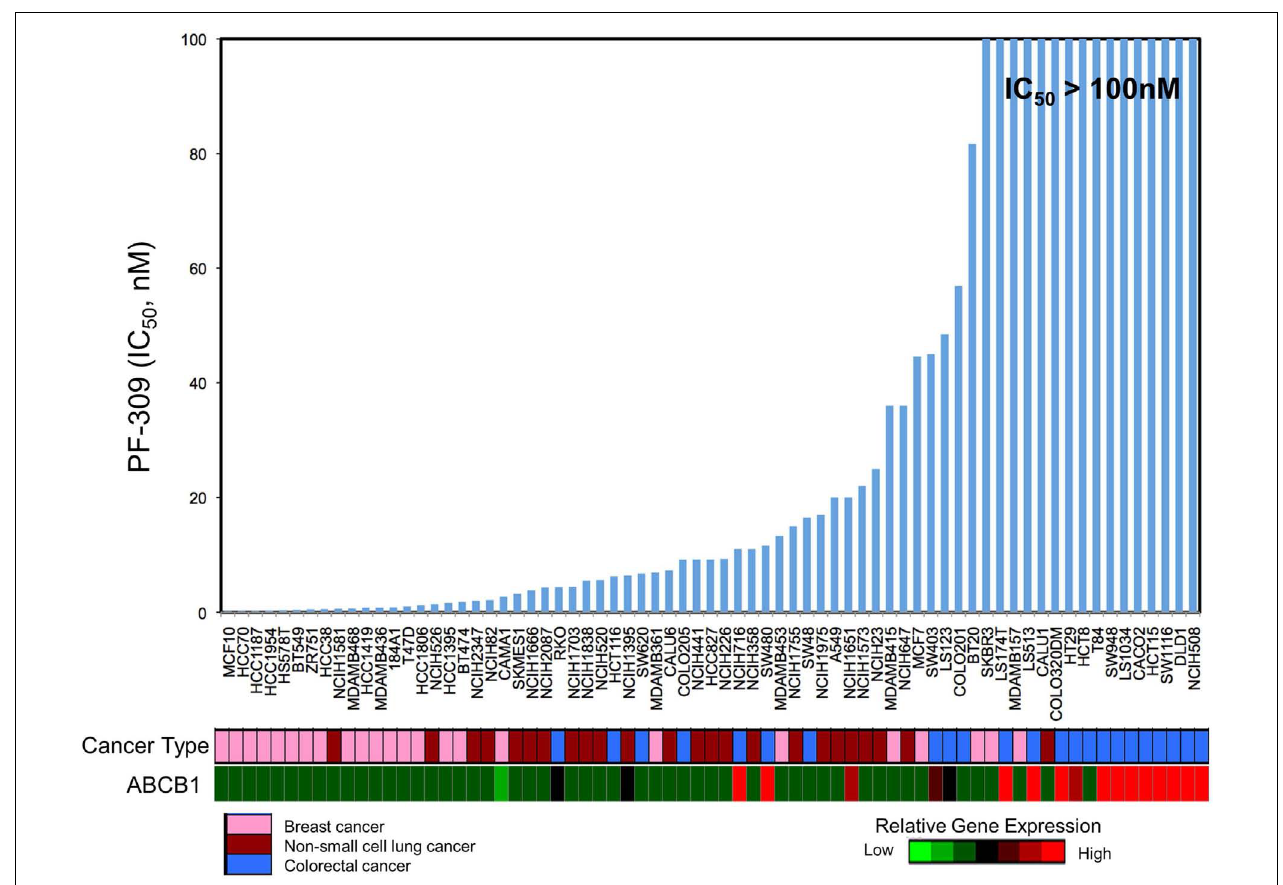
values established by resazurin (red represents high expression and blue/black represents low). Again, a significant correlation between ABCB1 gene expression and IC50 was found ( p <